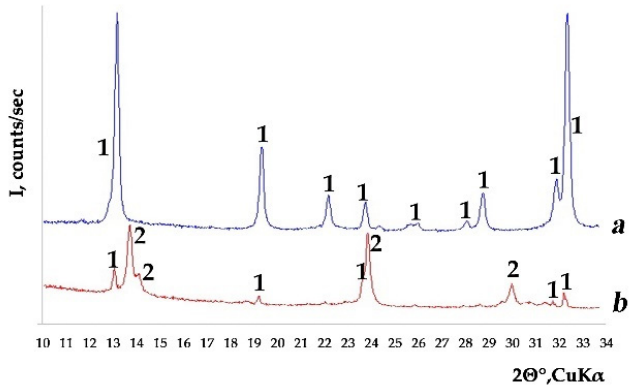
Figure 2. Typical XRPD patterns of the studied samples: ( a ) weddellite in Synthesis 30 and ( b ) whewellite and weddellite mixture in Synthesis 33. Designation: weddellite (1) and whewellite (2).